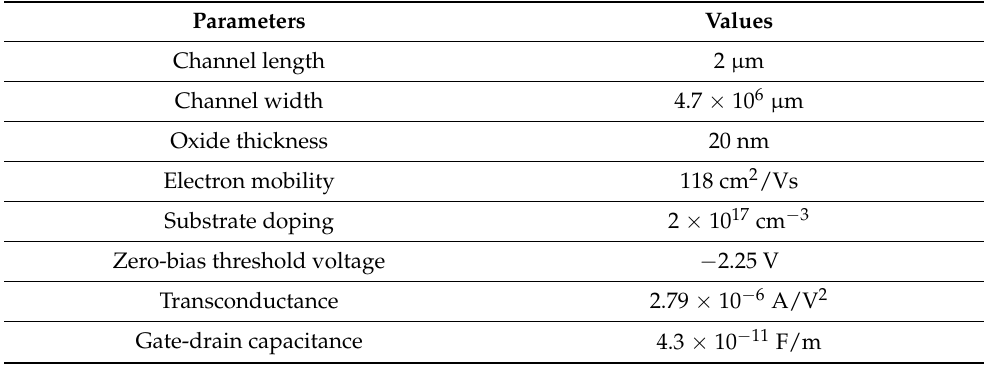
Table 2. Parameters used in SPICE for analyzing switching behavior of Ga 2 O 3 switches.